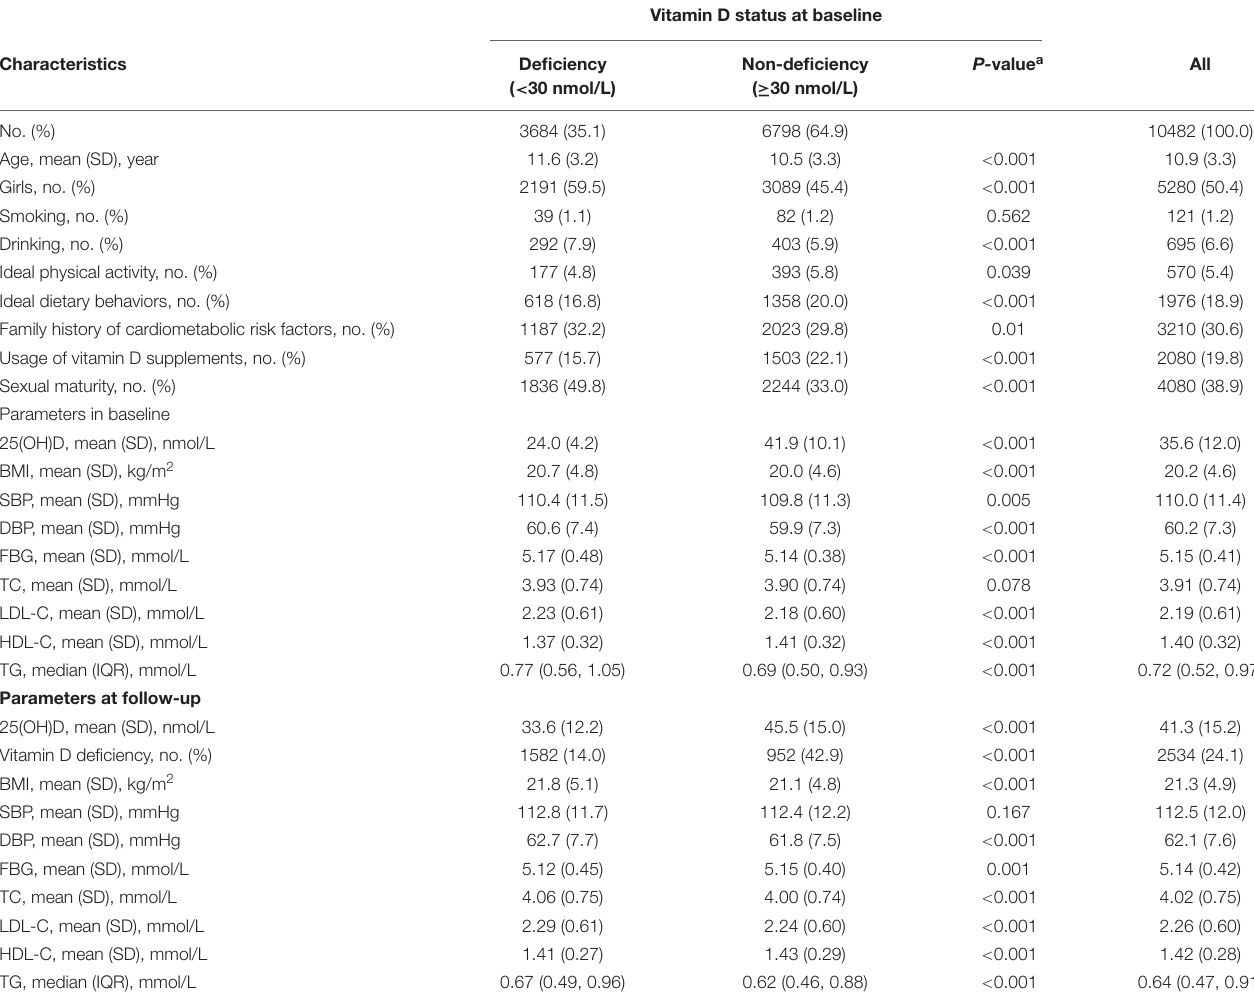
TABLE 1 | Characteristics of study population according to vitamin D status at